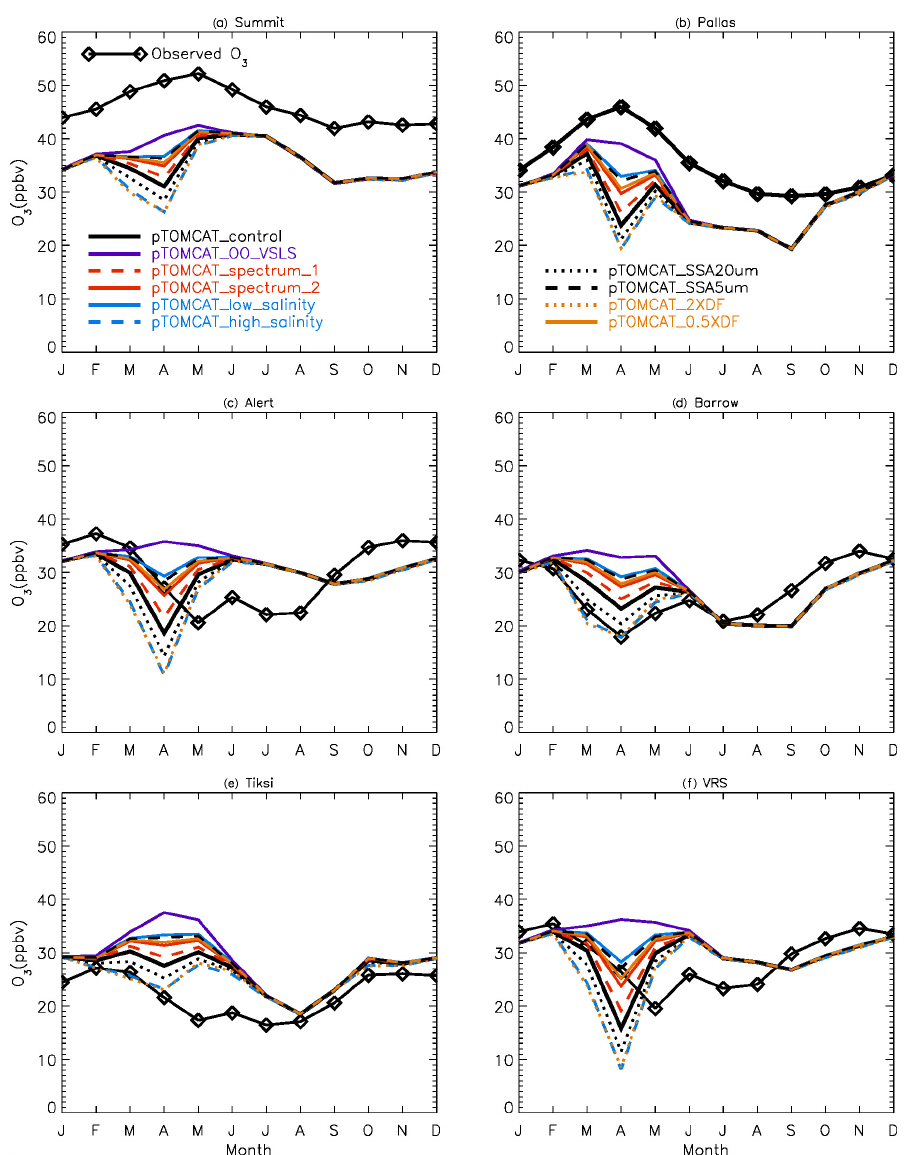
Figure 16. Monthly mean ozone at the six sites in the Arctic. Ozone observations are climatology, and simulated ozone outputs are only for the year